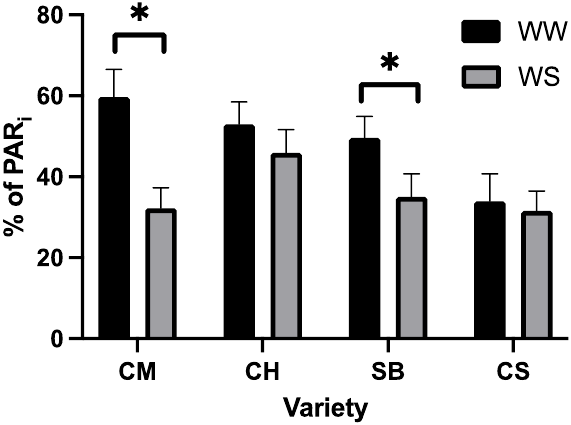
Figure 12. Incident light on leaves measured at midday, as a percent of the incident light above canopy (2350 mol photons m −2 s −1 ) in Carmenere (CM), Chardonnay (CH), Sauvignon blanc (SB) and Cabernet sauvignon (CS). WW, black bars and WD, grey bars. Error bars, represent SE. Single asterisk represents significant differences between treatments for each variety p ≤